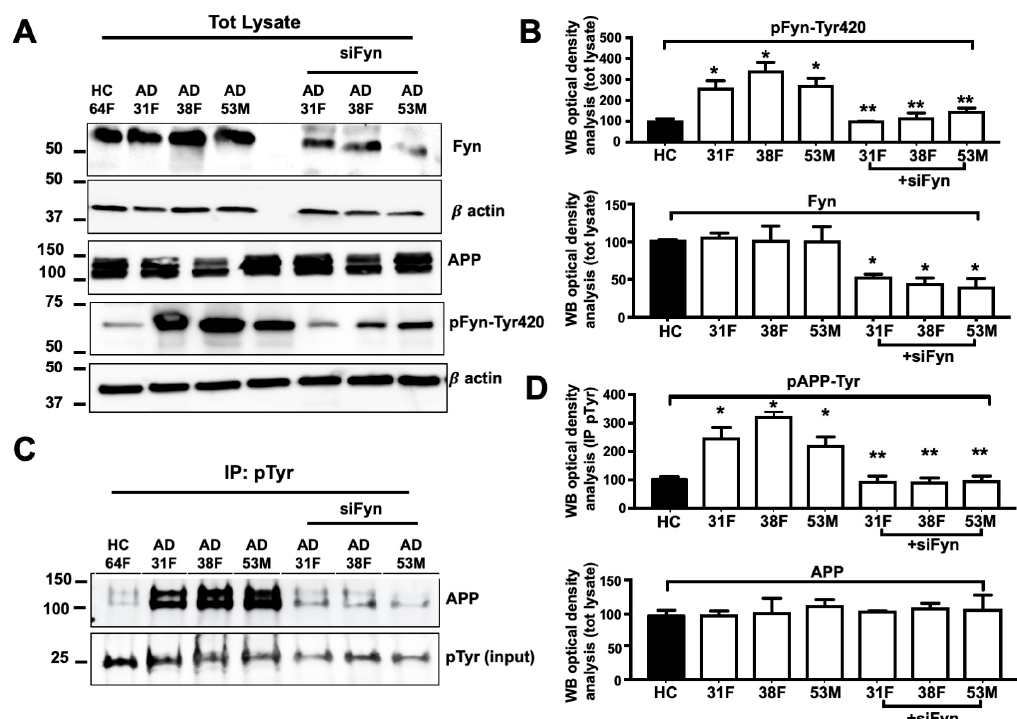
Figure 7. pAPP-Tyr levels decreased in Fyn knockout neurons from AD patients. ( A ) WB analysis of neural stem cells from one healthy control (HC, patient no. 64F) and three AD patients (the patient no. 31F, 38F, and 53M) before and after Fyn RNA silencing (siFyn). Forty-eight hours after Fyn siRNA transfection, neurons were collected and processed for WB using rabbit anti-Fyn, rabbit anti-Fyn pTyr420 (Src-pTyr416), rabbit anti-APP, and β -actin antibodies. Densitometric WB analysis is reported in ( B ). n = 3. * p < 0.05, vs. HC (one-way ANOVA followed by Dunnett’s post hoc test). ( C ) Total lysates were immunoprecipitated with mouse anti-pTyr magnetic beads (IP pTyr) and analyzed by WB using the rabbit anti-APP antibody. The optical density analysis is reported in ( D ). Values were calculated as a ratio of pAPP-Tyr relative to APP. pTyr levels were used as loading controls. n = 3. * p ≤ 0.05, vs. HC; ** p < 0.05, vs. the corresponding unsilenced neurons from AD patients (one-way ANOVA followed by Dunnett’s post hoc test).